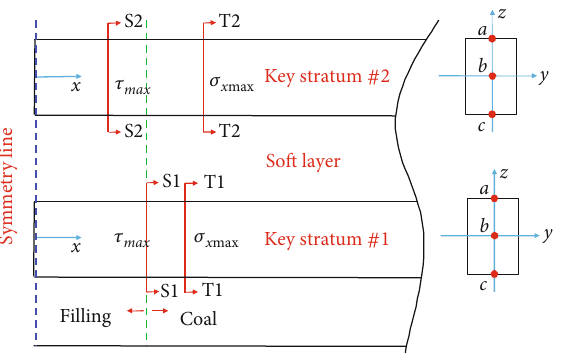
Figure 14: The section positions of the maximum tensile stress and shear stress.